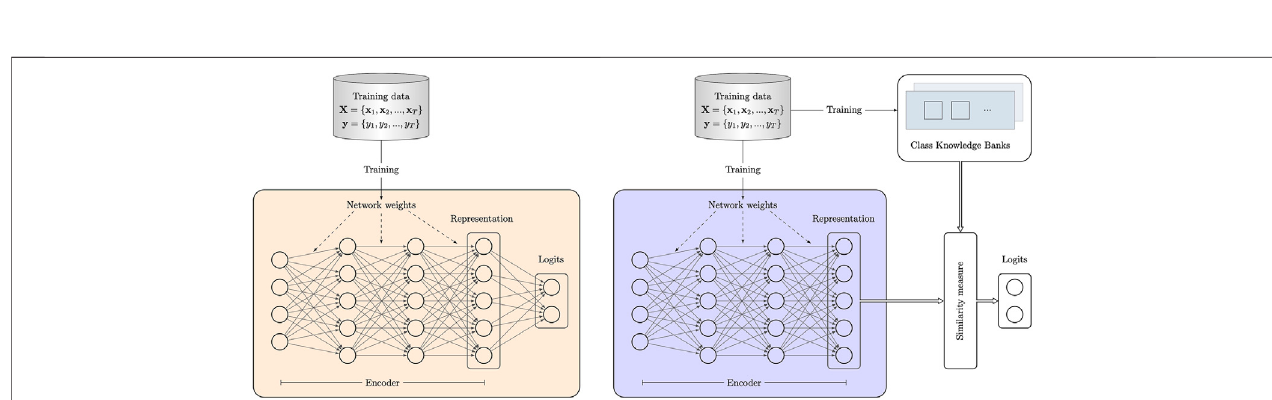
FIGURE 1 | Overview of the proposed network. The encoder and projection head embed the inputimage x into a representation r . The average similarity between the representation r and the unit u j i in the class knowledge bank (CKB) C i is measured as the logit of x for class i. The CKBs are parameterized by a matrix of dimension N × M × D ,where N isthenumberofclasses, M isthenumberofunitsineachCKB, andDdenotesthedimensionofaunit.TheCKBsarerandomlyinitializedandcanbe trained through back-propagation.